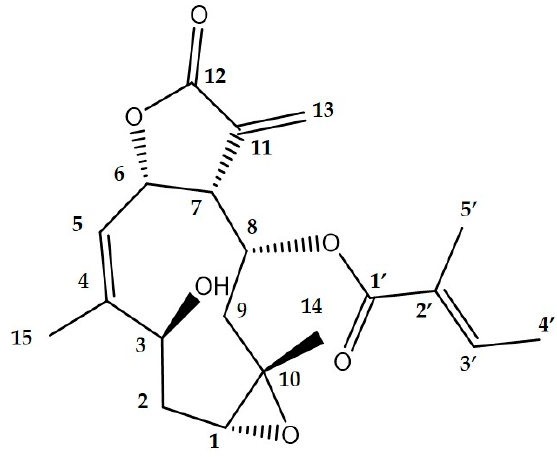
Figure 1. The structure of heliangin.